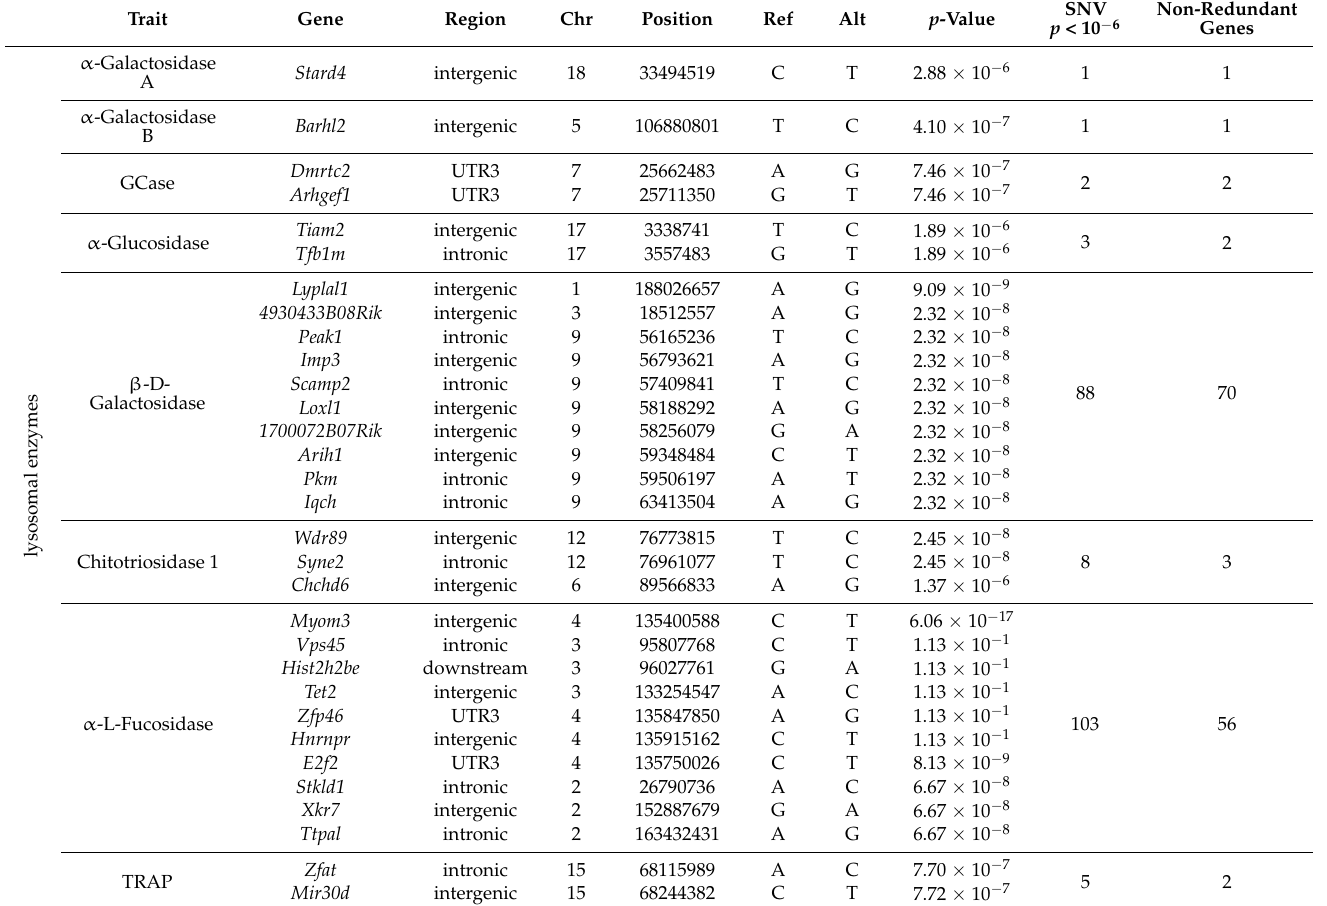
Table 1. Summary of the putative modifier genes of enzymatic activity and GSLs levels identified by